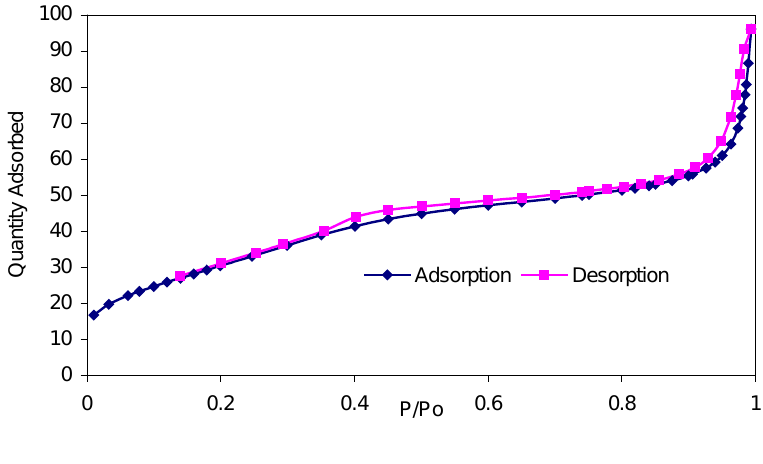
Figure 2. Nitrogen adsorption-desorption plot of sulfated